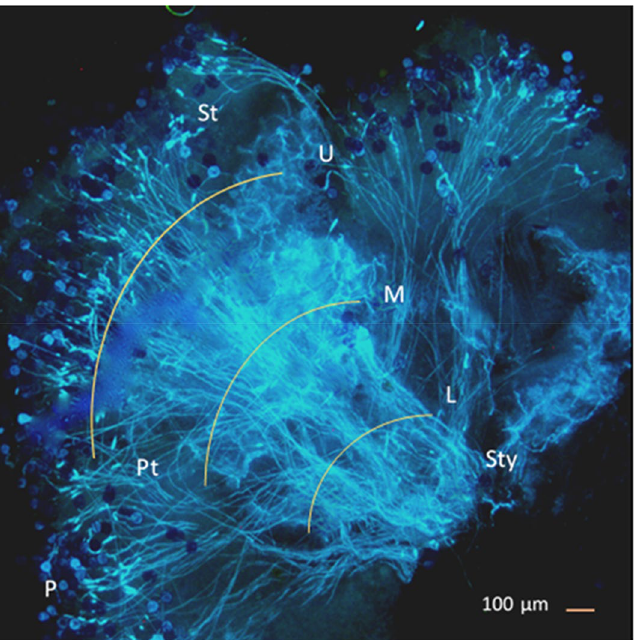
Figure 6. A fluorescence micrograph of a pistil showing pollen grains (P) on the stigma (St), and pollen tubes (Pt) in the upper (U), middle (M) and lower (L) 1/3 of the of style